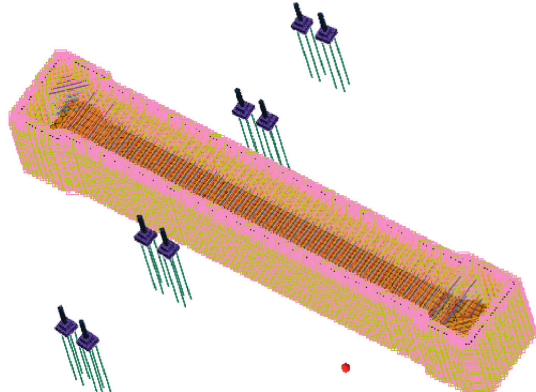
Figure 9: Model map of the foundation pit of the metro